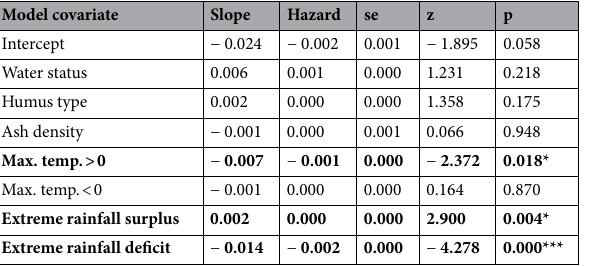
Table 3. Summary statistics from Aalens additive regression model. Significant covariates are marked in bold. * significant at p<0.05, *** significant at p<0.001.